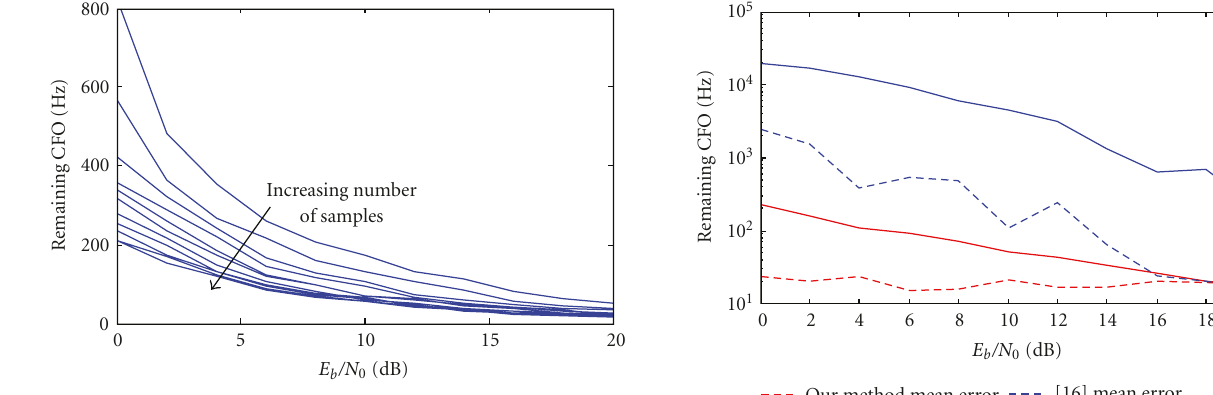
Figure 4: Estimated CFO standard deviation versus the number of samples in J ( w ).